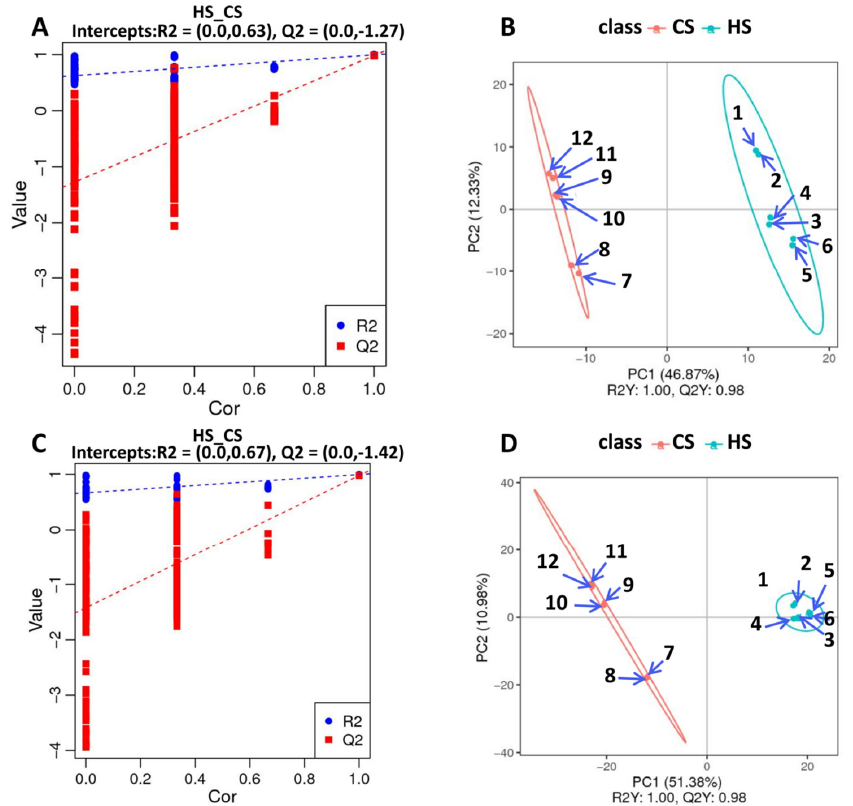
Figure 4. PLS-DA dispersion point diagrams and sorting verification diagrams: ( A ) PLS-DA dispersion point diagram (negative ion mode); ( B ) PLS-DA sorting verification diagram (negative ion mode); ( C ) PLS-DA dispersion point diagram (positive ion mode); ( D ) PLS-DA sorting verification diagram (positive ion mode).